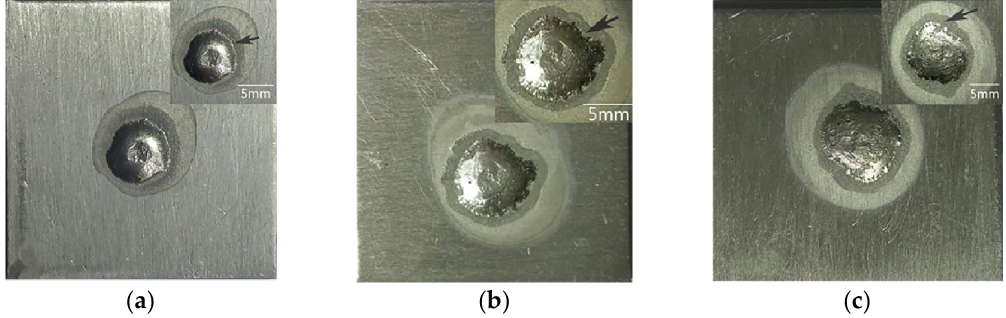
Figure 15. Macro morphology of SnZn–Al 2 O 3 composite solders after wetting on the 6061-aluminum alloy: ( a ) 0% Al 2 O 3 ; ( b ) 0.5% Al 2 O 3 ; ( c ) 1.0% Al 2 O 3 [90].